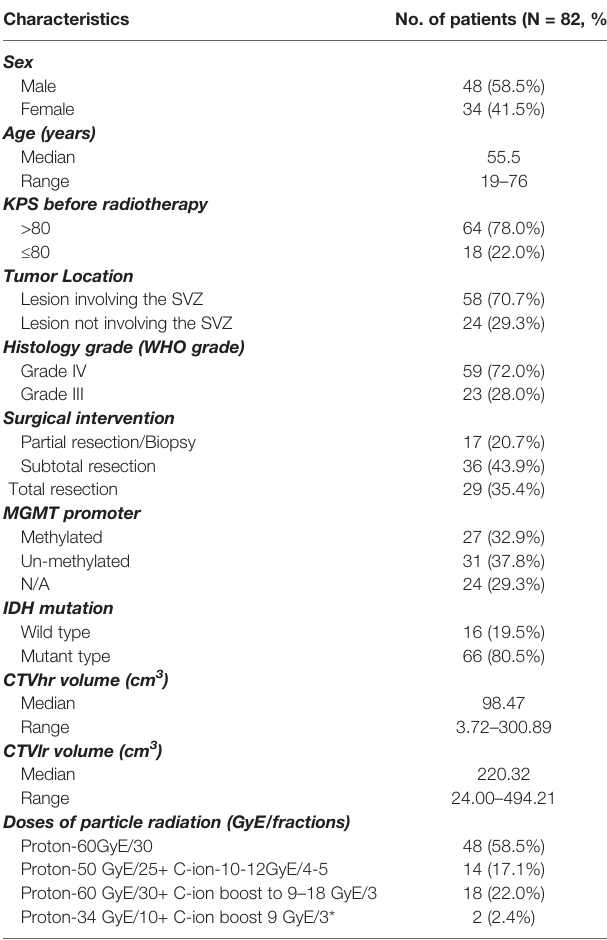
TABLE 1 | Characteristics of all 82 patients, their condition, and treatment.